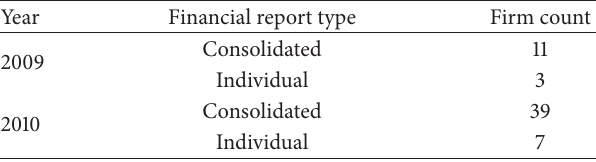
Table 2: Financial report counts with early K-IFRS adoption.